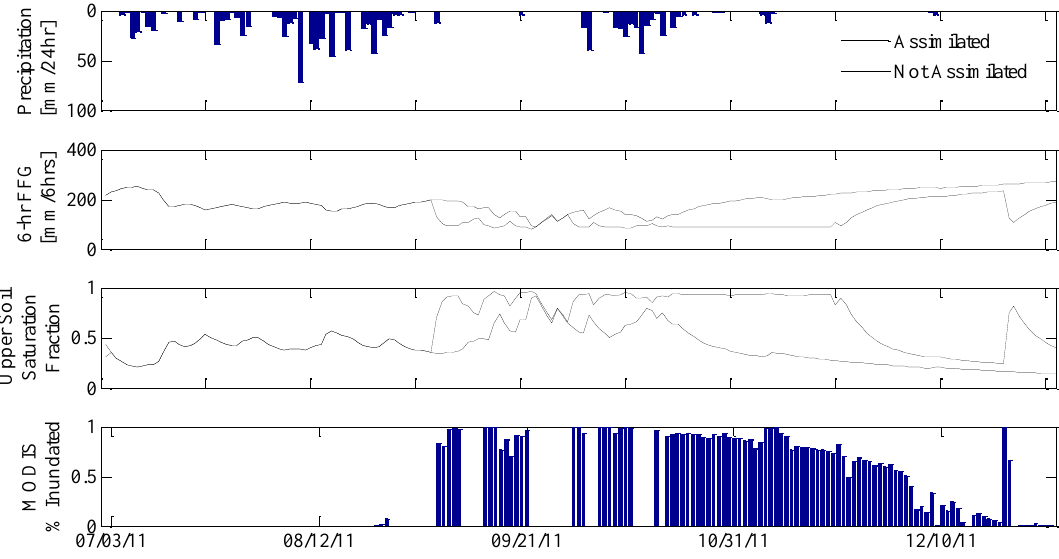
0 20 40 Figure 15. Forcing variables and modeling results for the hydrologic response of Basin No. 10171: ( a ) precipitation, ( b ) the 6-hr Flash Flood Guidance value (in mm/6hrs), ( c ) soil moisture saturation fraction, and ( d ) the fraction inundated.